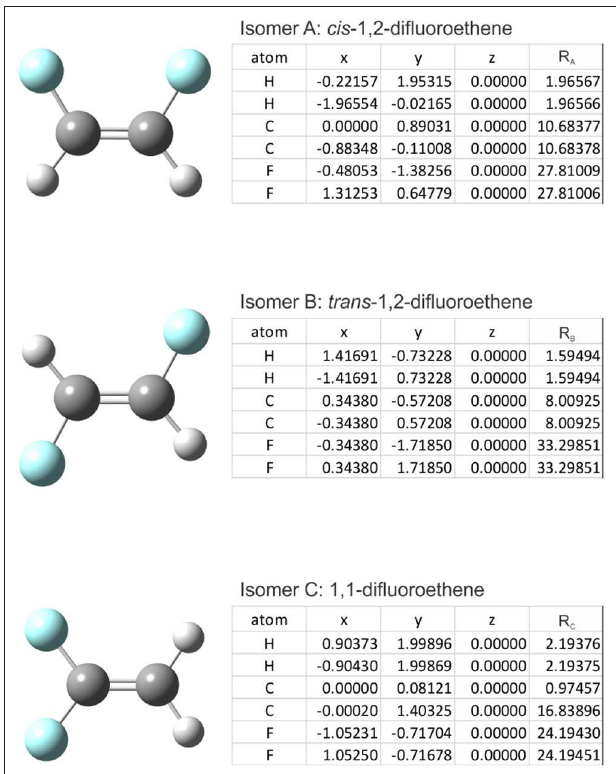
FIGURE 2 | The structures of (top) cis -1,2-difluoroethene, (middle) trans -1,2-difluoroethene, and (bottom) 1,1-difluoroethene. (Inset Tables) atomic coordinates and the mass-weighted distance vectors. Geometries were optimized at the PM6 level of theory as implemented in Gaussian 16 ( Frisch et al., 2016).